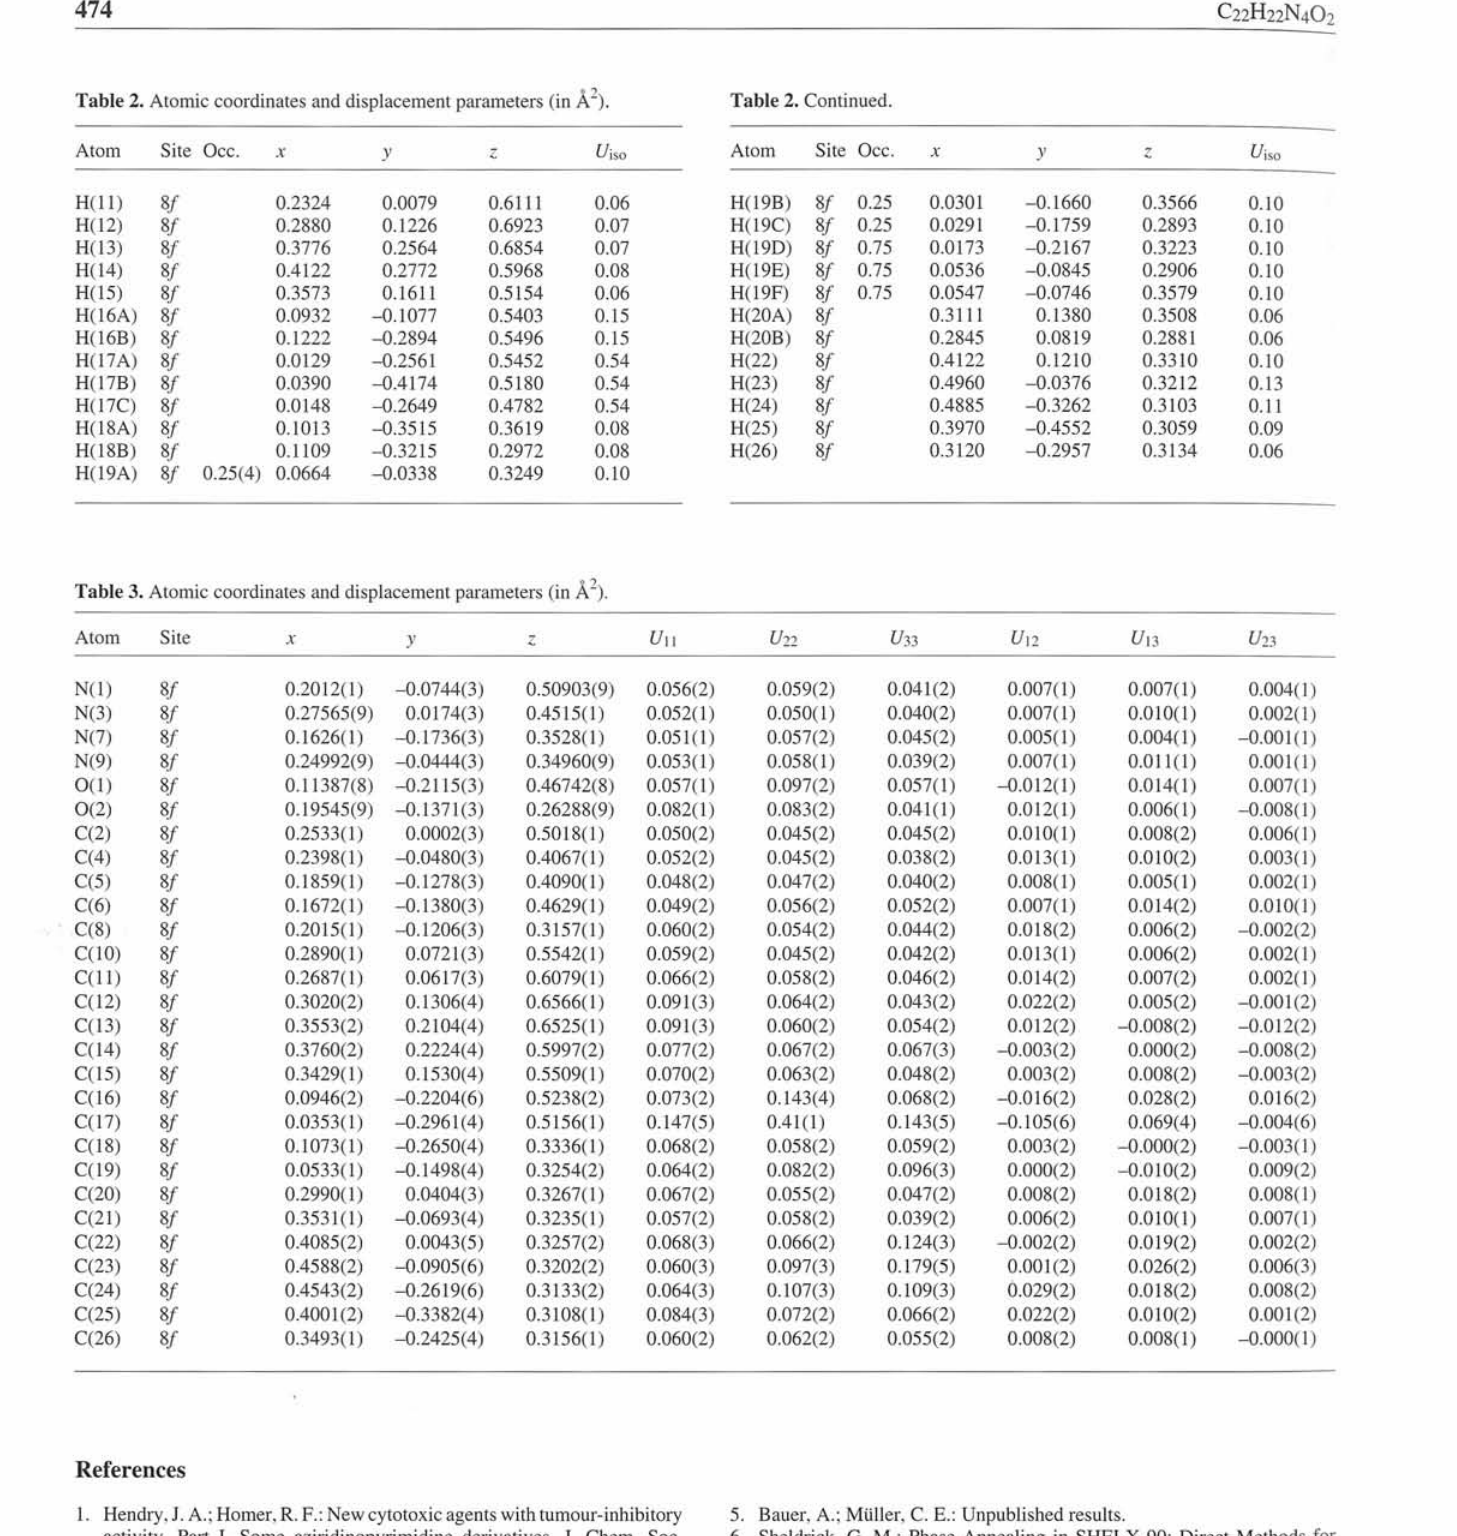
Table 3. Atomic coordinates and displacement parameters (in Â 2